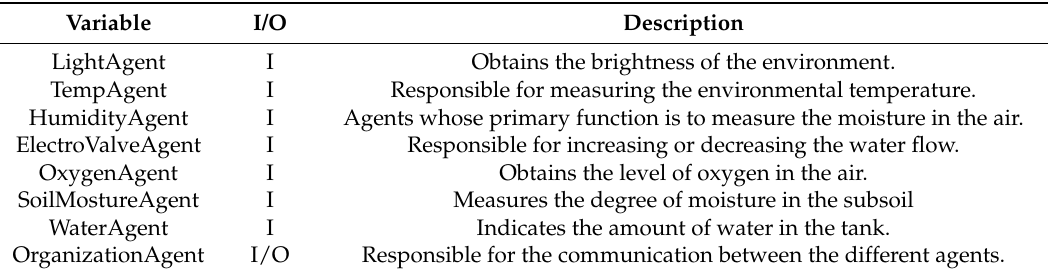
Table 1. Monitoring